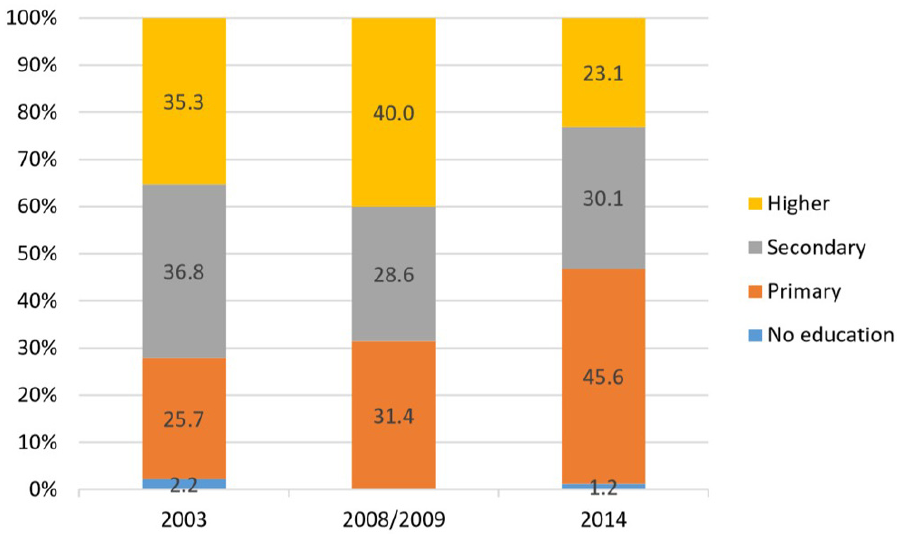
Figure 5. Intrauterine device use by education, 2003–2014.